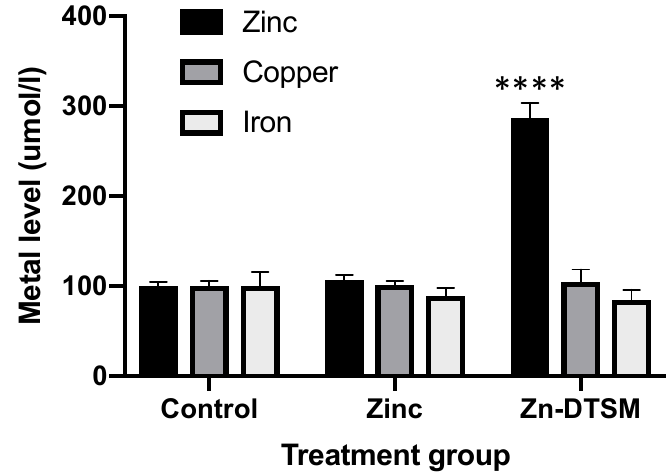
Figure 2. Ionophore data showing that cellular metal content in SH-SY5Y cells is not significantly altered by increasing exogenous zinc levels (10 µM), but the addition of 10 µM zinc diethyl bis(N4-methylthiosemicarbazone) (Zn-DTSM) significantly increases intracellular zinc. There is no significant effect of Zn-DTSM on either copper or iron levels. Data are mean ± SEM. **** p <0.0001.